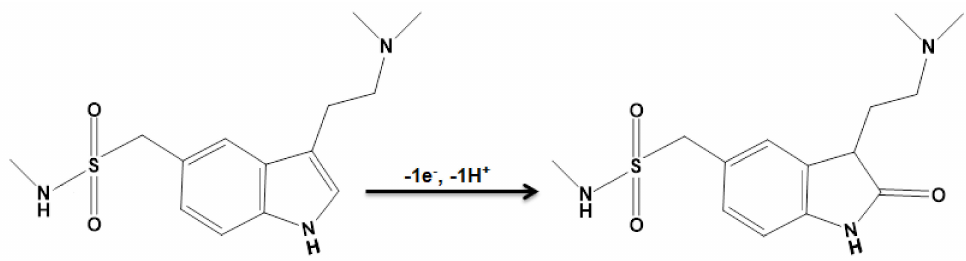
Figure 4. Proposed oxidation mechanism for sumatriptan.